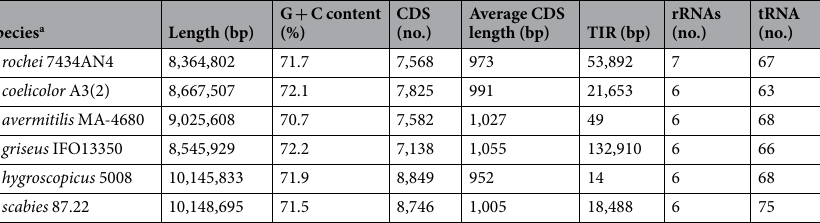
Table 1. General features of the chromosomes of Streptomyces rochei 7434AN4 and five other Streptomyces species. a GenBank accession number: S. rochei 7434AN4 chromosome, AP018517; S. coelicolor A3(2),